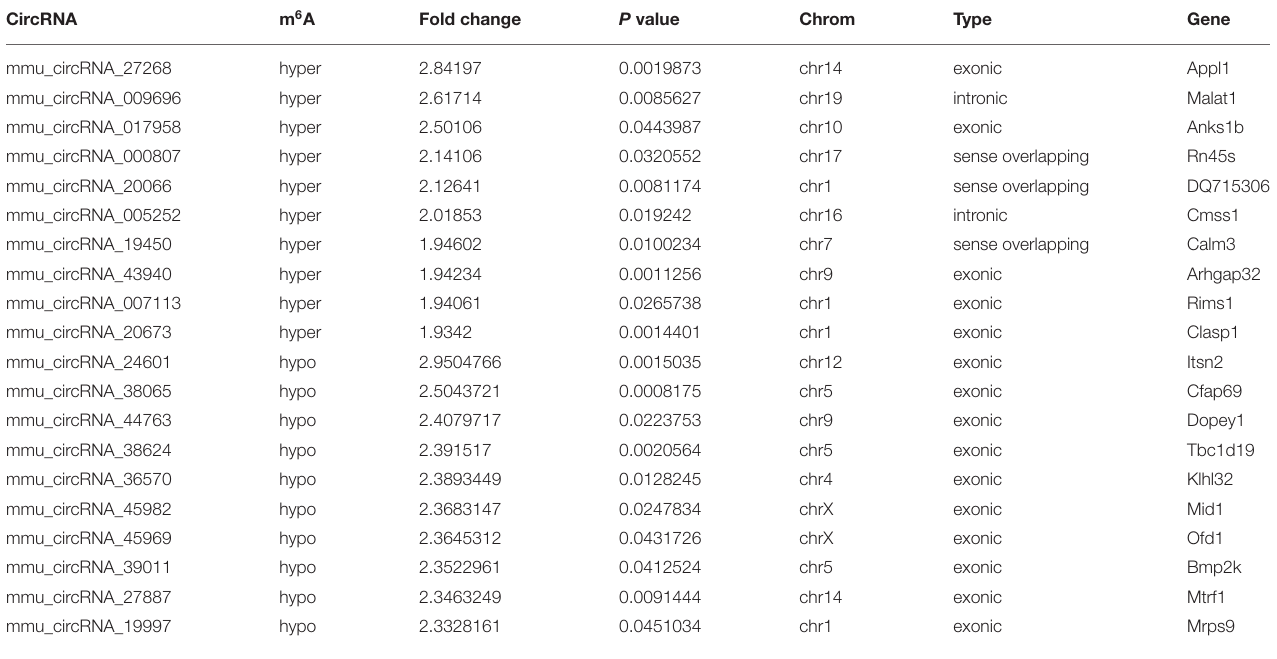
TABLE 2 | The top 10 hyper and hypo-methylated circRNAs between 3d vs. sham.